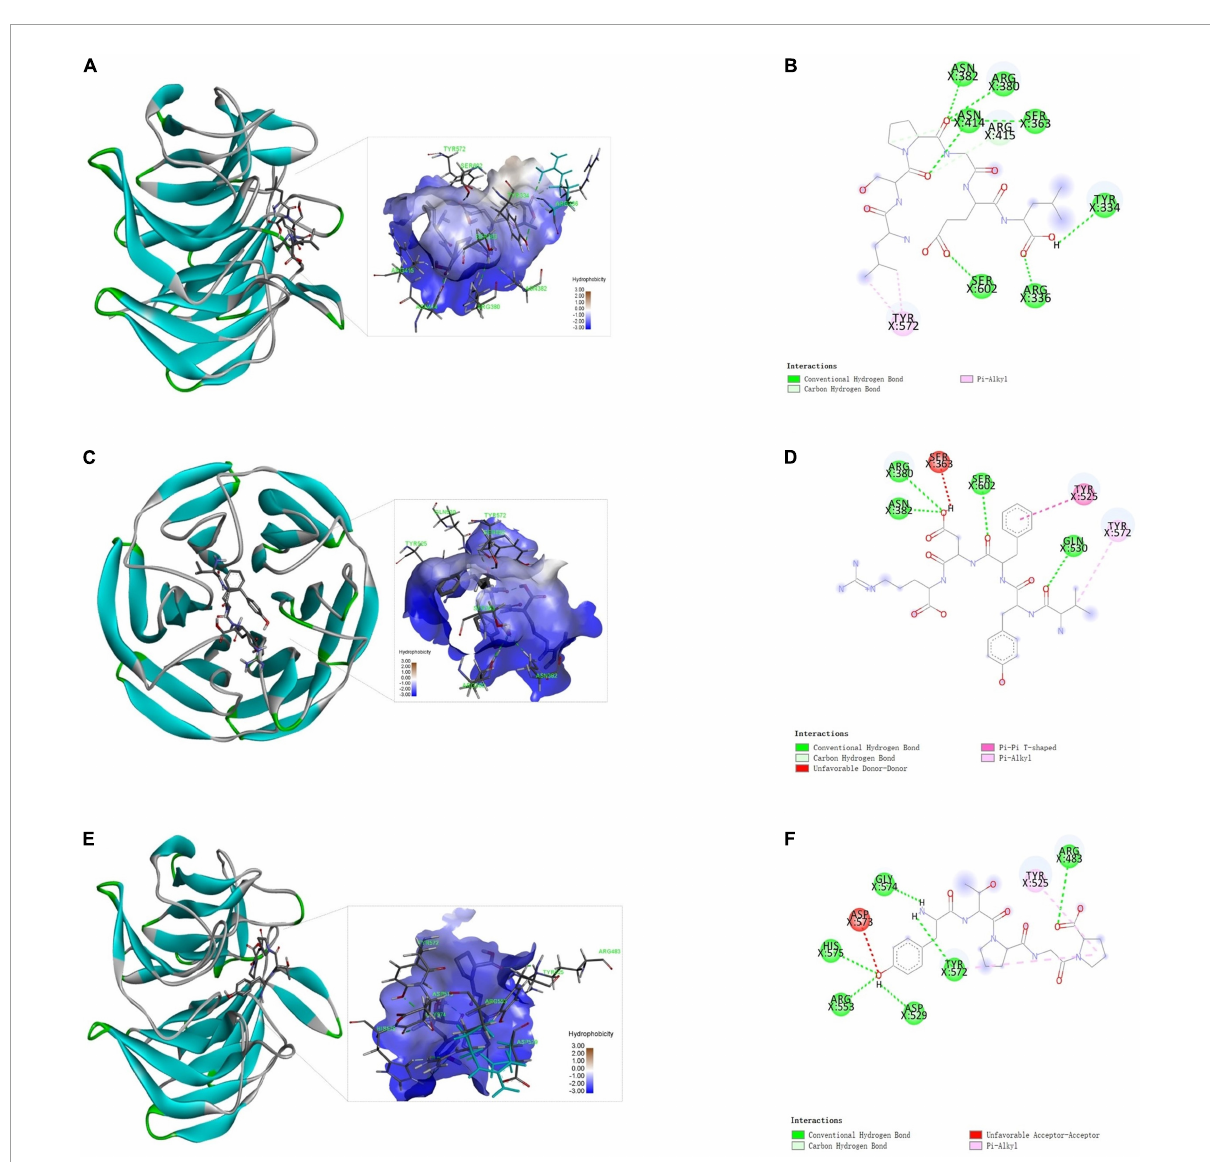
FIGURE5 Docking results of Keap1 and the peptides. Three-dimensional (A) and two-dimensional (B) structure diagrams of LSPGEL and Keap1; three-dimensional (C) and two-dimensional (D) structure diagrams of VYFDR and Keap1; three-dimensional (E) and two-dimensional (F) structure diagrams of PGPTY and